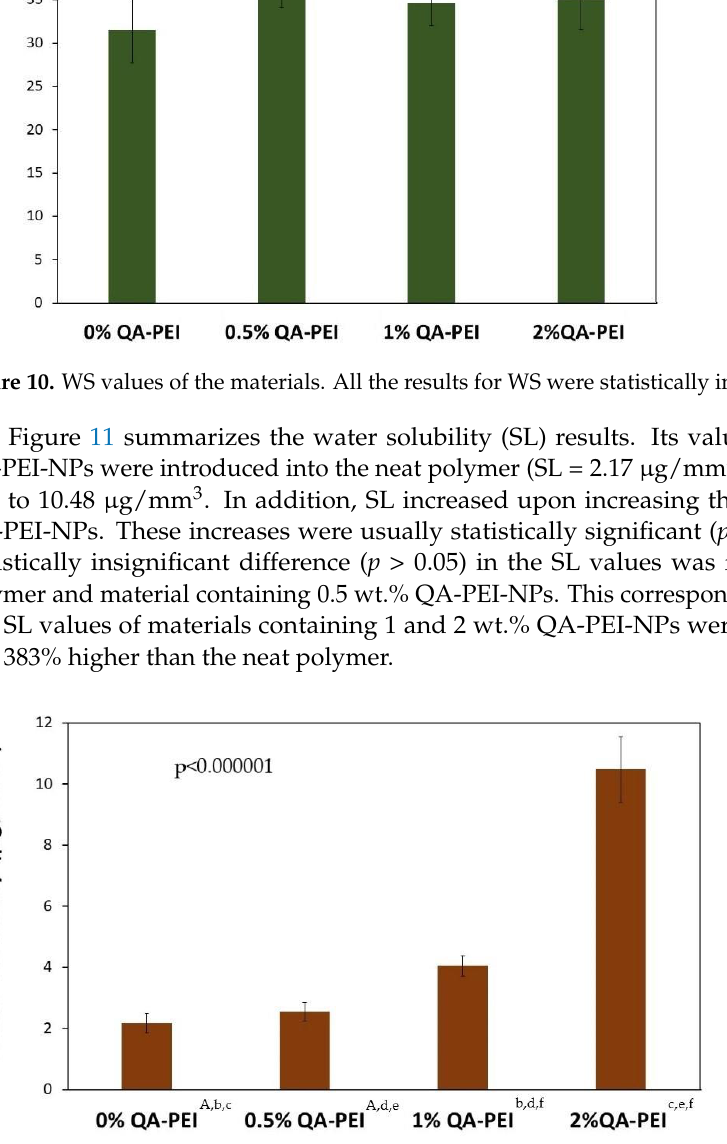
Figure 11. SL values of the materials. Statistically significant differences ( p ≤ 0.05) are marked with the lower case letters, whereas statistically insignificant differences ( p > 0.05) are marked with the upper case letters.